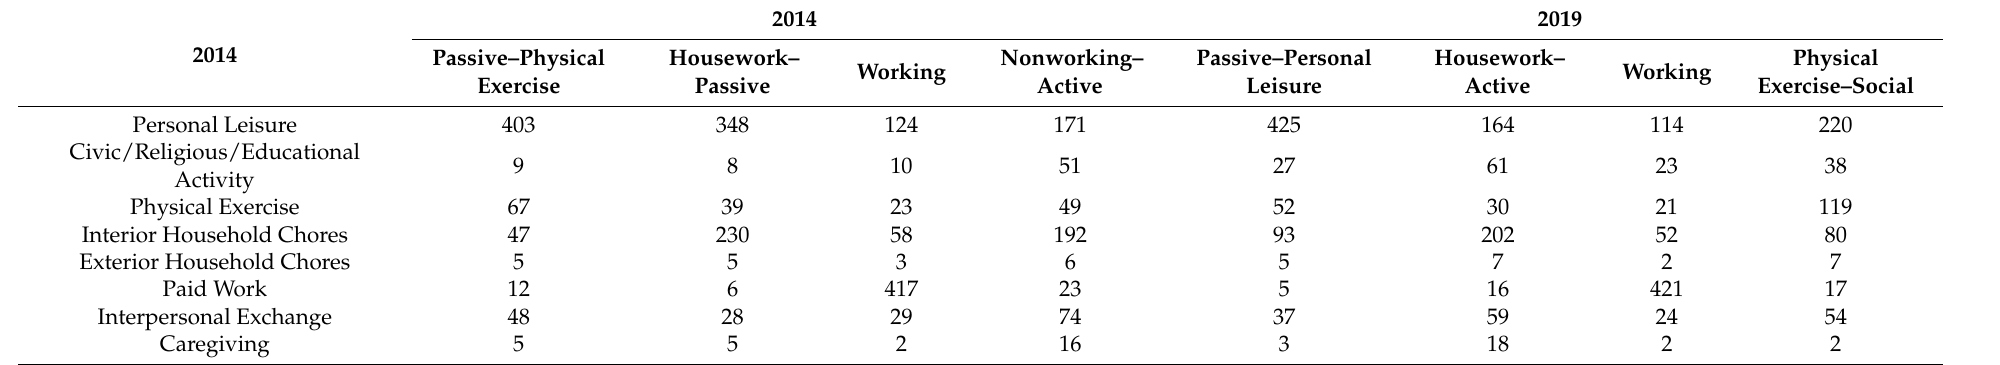
Table 4. Average time spent on each activity domain (measured as minutes per